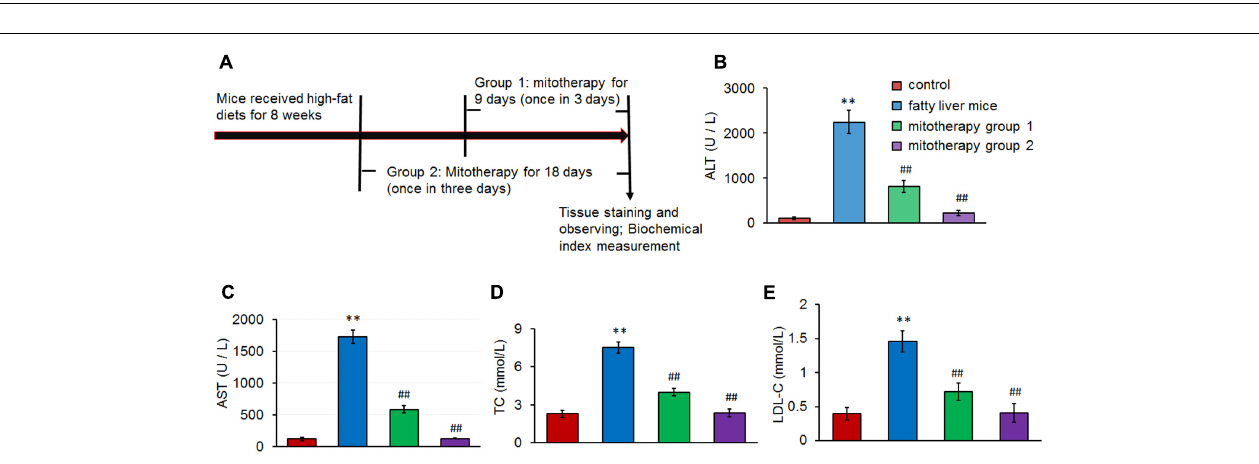
FIGURE 2 | Distribution in vivo of the GFP-tagged mitochondria after intravenous administration. Tissue fluorescence was evaluated by tissue imaging (A) and tissue sections (B) .